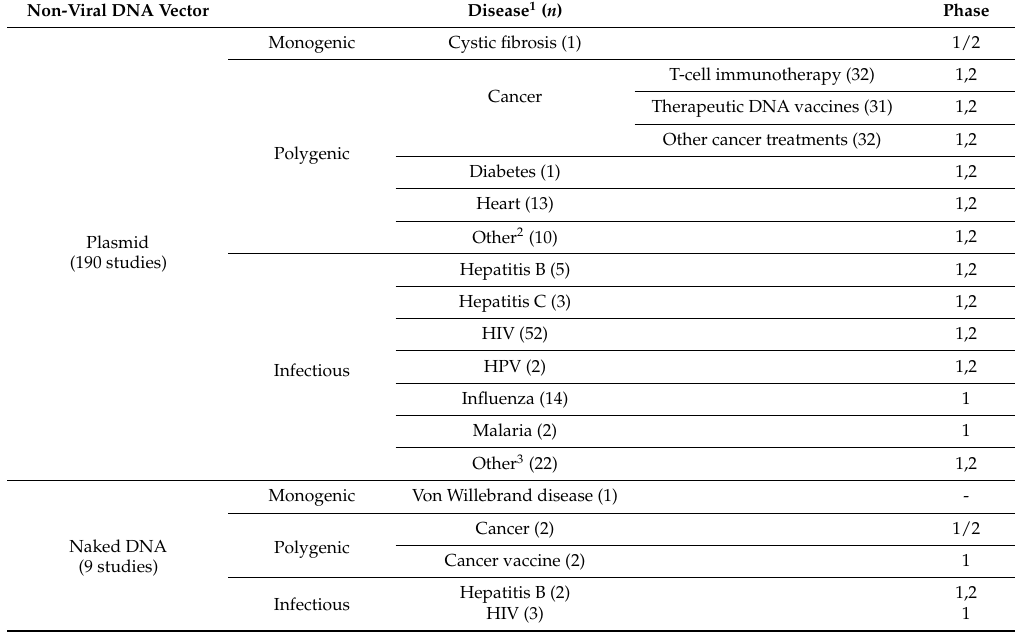
Table 1. Non-replicating non-viral DNA vectors in gene therapy